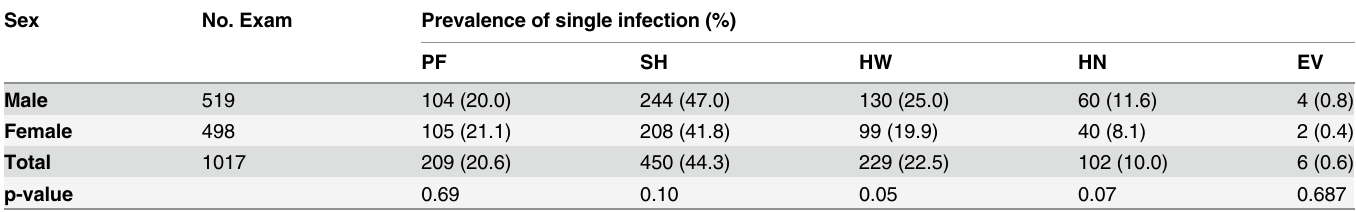
study. In all, males were generally more infected with all the intestinal helminths and the differ- ence was not significant. Similarly for P . falciparum parasitaemia, female (21.1%) were slightly more infected than males (20.0%) but the difference was not statistically significant (p = 0.69). The prevalence of polyparasitism based on age and sex in the study population is shown in Table 4. Polyparasitism was generally higher among the male children but the difference was not statistically significant. No significant difference was also observed when total polyparasit- ism was compared between the age groups (p = 0.20) The association between the presence of malaria parasitaemia and intestinal helminths among the study subjects is shown in Table 5. There was a statistically significant association between P , falciparum and S . haematobium (p = 0.04), P . falciparum and hookworm (p = 0.01) with a Relative Risk of 1.3 and 1.4 respectively. Children who were infected with S . haemato- bium (RR = 1.3) and hookworm (RR = 1.4) have equal chances of likely being infected with P . falciparum as children with no worm infection. On the other hand, children exposed to Hyme- nolepis spp. (p < 0.0001) are more likely to be infected with P . falciparum than Hymenolepis A logistic regression analysis was carried out to determine the occurrence of anemia among